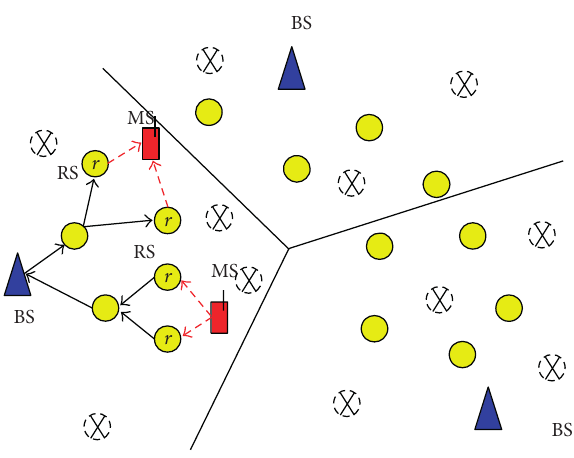
Figure 2: Network separations with several BSs.